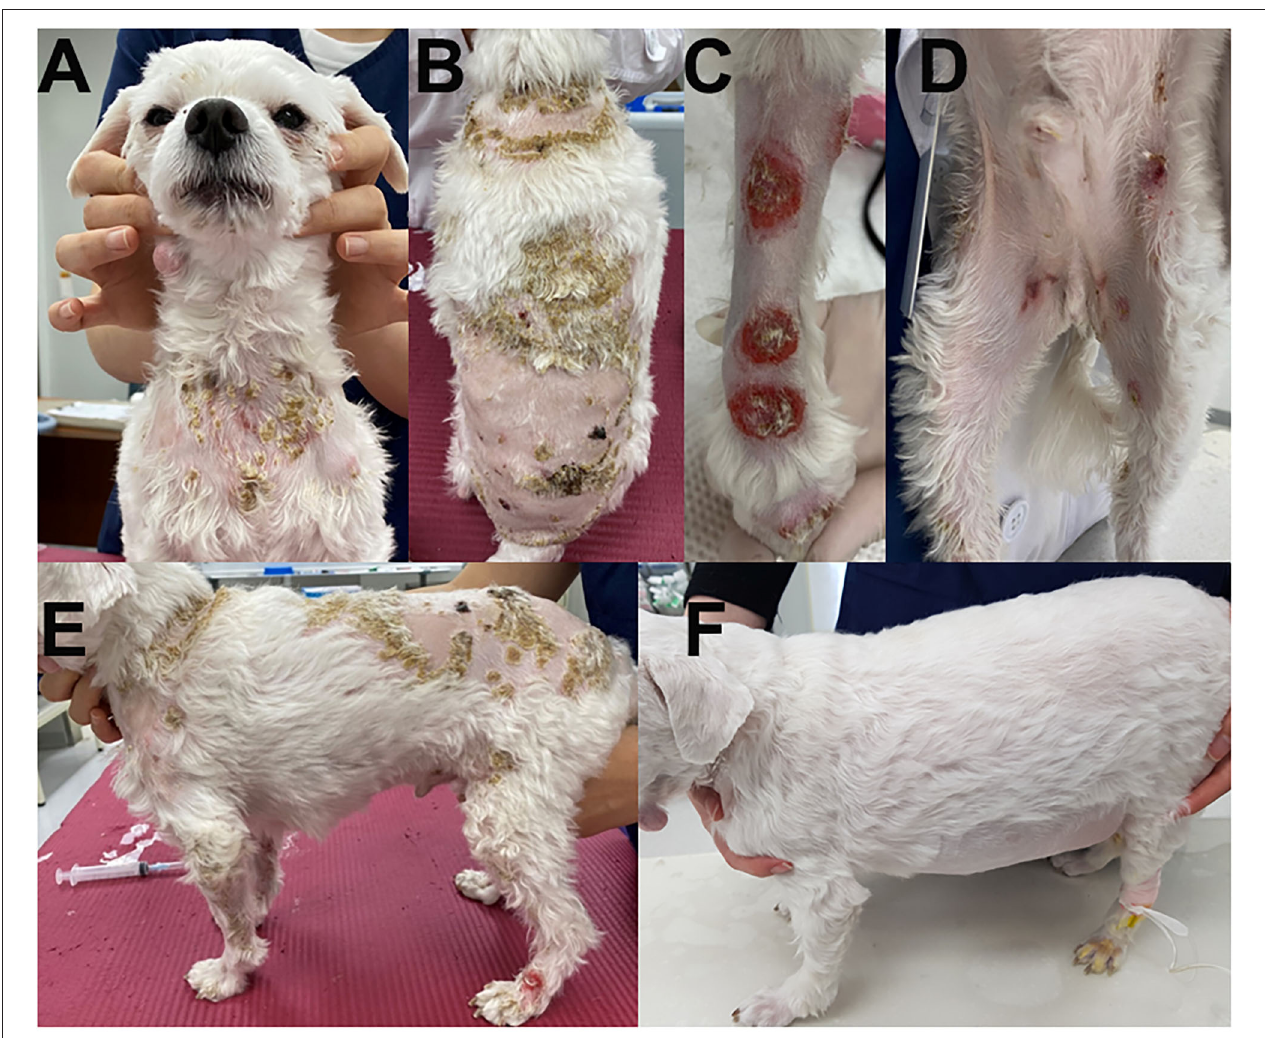
FIGURE 1 | Clinical images of the skin lesions. Crusts were present on the neck (A) and dorsal trunk (B) ; clearly demarcated plaques on the forelimbs (C) , and multiple ulcerations on the inguinal region (D) . Generalized skin lesions are shown on admission (E) and after steroid treatment (F)